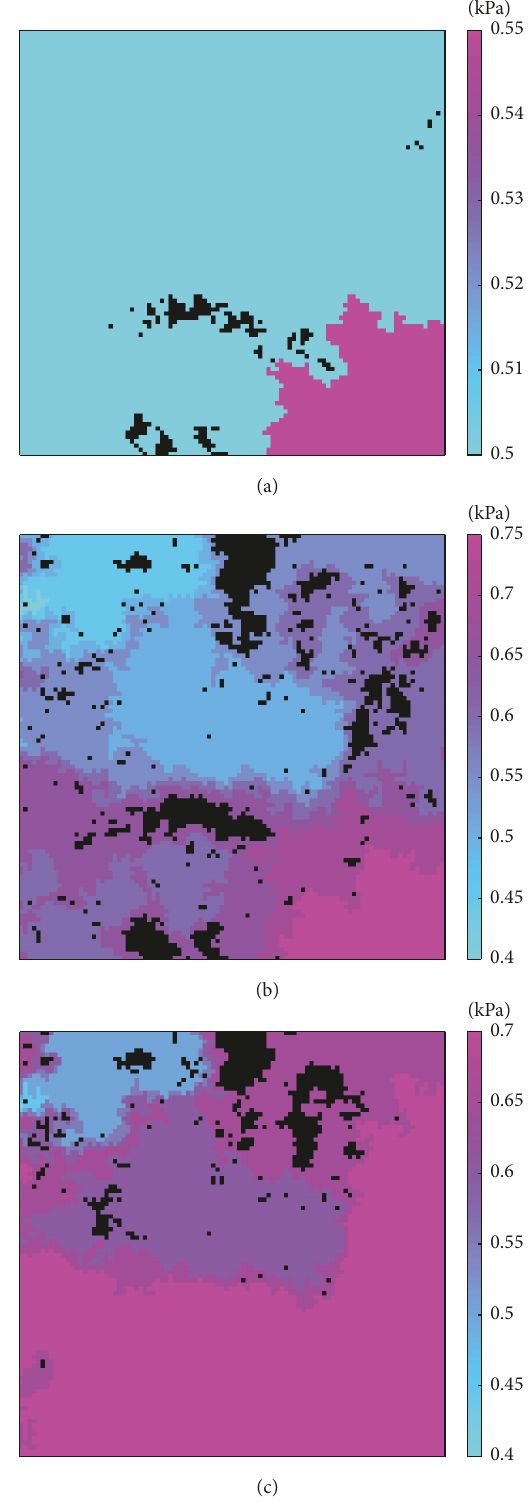
Figure14:Watersaturationmapswithdifferentstandarddeviations: (a) 𝜎 = 0.01 mm; (b) 𝜎 = 0.10 mm; (c) 𝜎 = 0.24 mm.